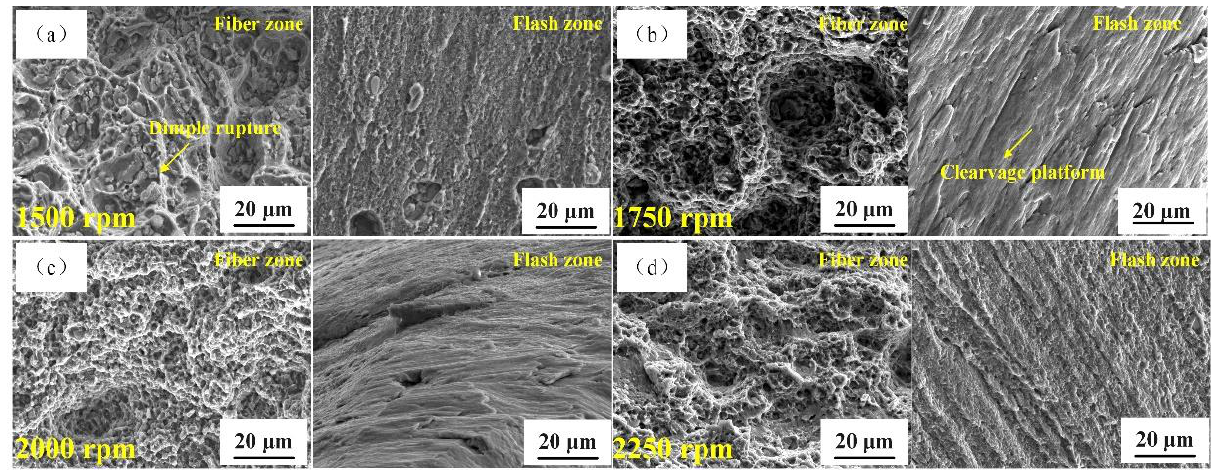
Figure 15. Fracture morphologies of the T-joint’s rib plate at different rotation speeds of the stirring pin: ( a ) 1500 rpm; ( b ) 1750 rpm; ( c ) 2000 rpm; ( d ) 2250 rpm.